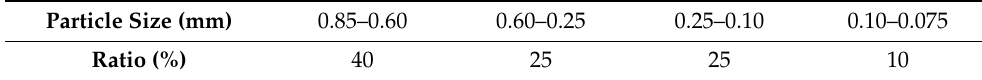
Table 2. Particle size and ratio of sand for well-graded sand.